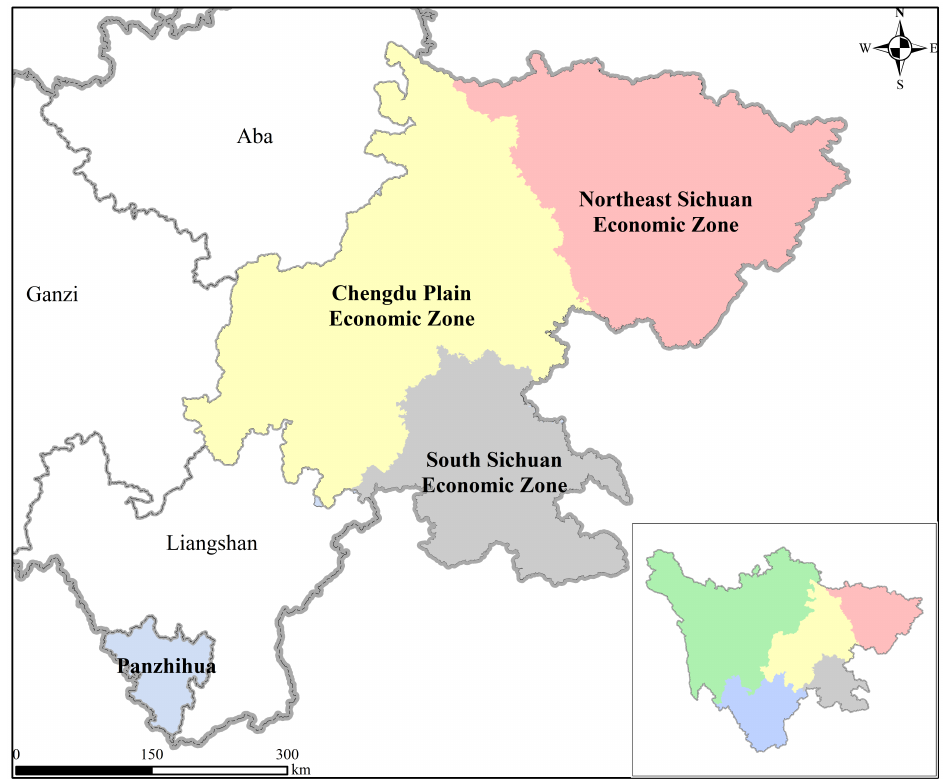
Figure 5 Figure 5. Location of economic zones.